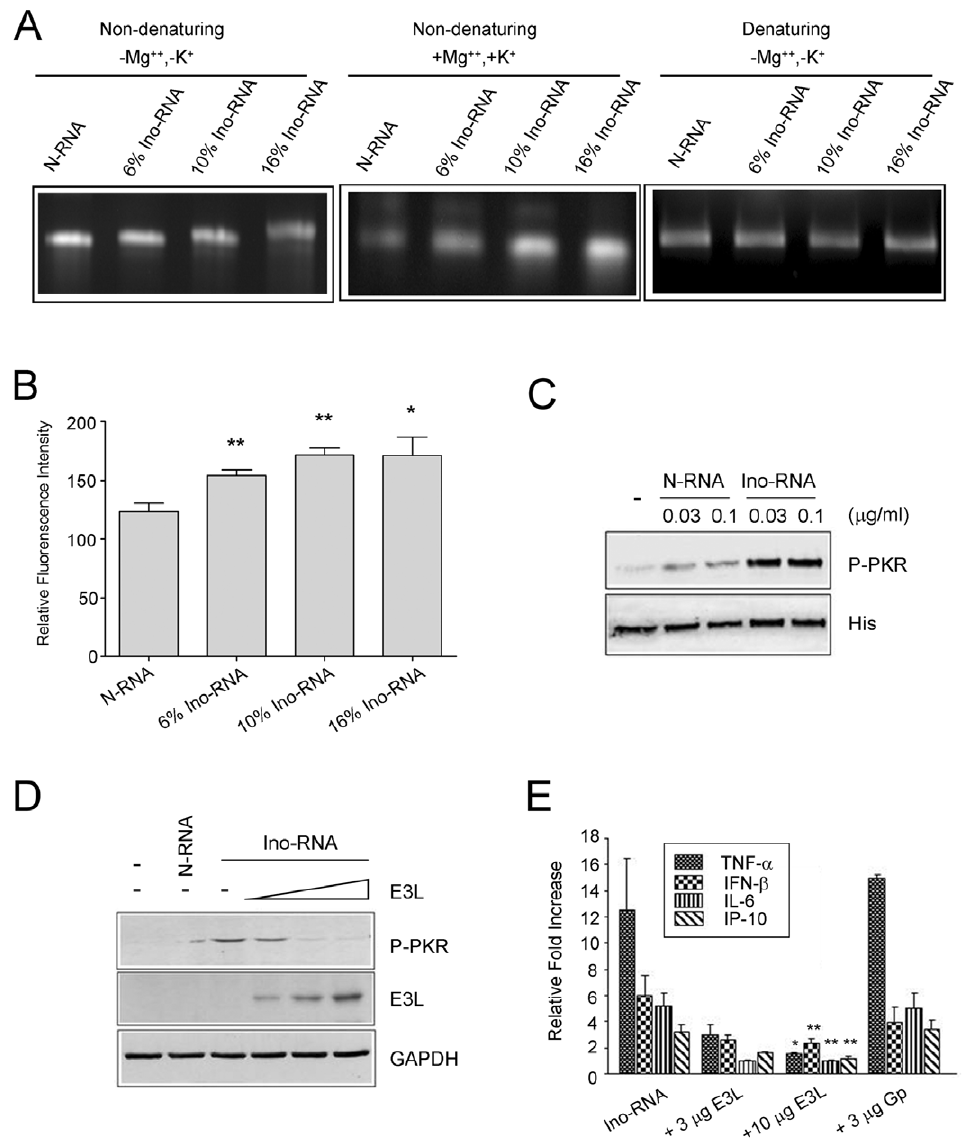
Figure 5. Inosines incorporation increases secondary structures of RNA. Panel A , N-RNA, 6%, 10% and 16% Ino-RNA were electrophoresed on non-denaturing or denaturing agarose gels in the absence or presence of MgCl 2 and KCl. Panel B , RNA secondary structures were determined by acridine orange staining in the presence of MgCl 2 and KCl followed by fluorescence spectral analysis. Panel C , Direct interaction of purified recombinant PKR with Ino-RNA was examined by in vitro kinase reaction followed by western blot analysis. Panel D , BEAS-2B cell extracts were used in in vitro kinase reaction in the presence of N-RNA (3 m g/ml), 10% Ino-RNA alone (3 m g/ml) or Ino-RNA incubated with increasing amounts of dsRNA- binding protein E3L at 50, 100 and 200 ng. Panel E , PHBE cells were treated with 10% Ino-RNA alone, with Ino-RNA and E3L, Ino-RNA and Galpha-i protein (G p ) (as a negative control). After 2 hr of incubation, total RNA was collected and RT-PCR reaction was performed (n $ 3, 6 SEM, *p , 0.05, **p ,